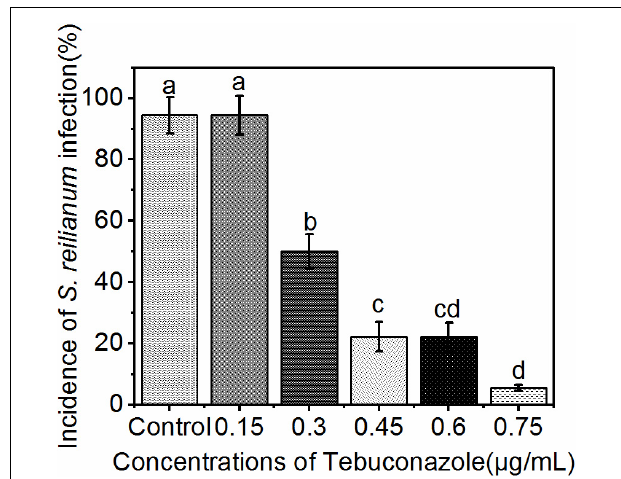
FIGURE 6 | Incidence of S. reilianum infection in sorghum seedlings determined by positive PCR reactions. Sorghum seeds were treated with five different concentrations of tebuconazole (x-axis), then planted in soil containing 0.2% (by weight) teliospores of S. reilianum and grown 7 days. Each bar represents the mean ± se ( n = 3) level of disease incidence (y-axis). Different lowercase letters indicate a significant difference between the different concentration of tebuconazole ( p < 0.05).